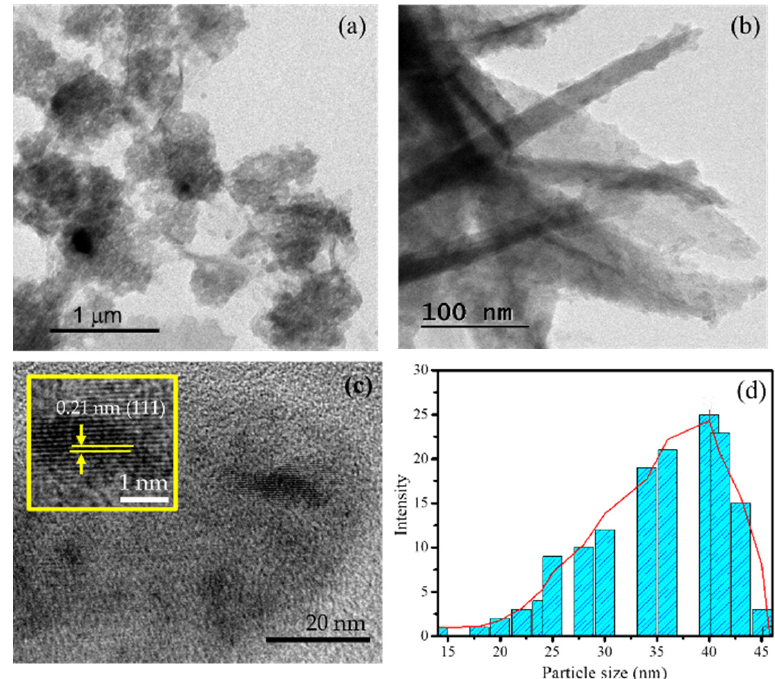
Figure 3. ( a , b ) TEM images of Ni/BC; ( c ) HRTEM image of Ni NPs; ( d ) Pore size distribution.